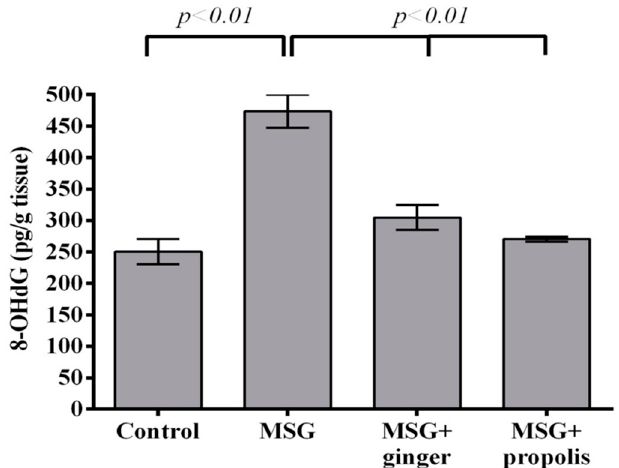
Figure 16. Cerebral cortex DNA 8-OHdG biomarker of oxidative stress two months after oral MSG administration with or without ginger or propolis. Data are expressed as mean ± SEM ( n = 6). Comparisons were made between normal control and MSG control groups, and between MSG control and MSG plus ginger or propolis supplement groups as well.